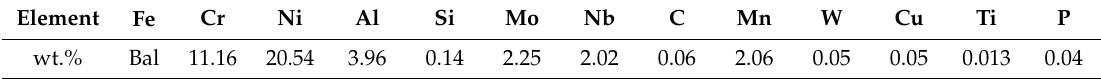
Table 1. Chemical composition of alumina-forming austenitic heat-resistant (AFA) steel (mass%). Element Fe Cr Ni Al Si Mo Nb C Mn W Cu Ti P wt.% Bal 11.16 20.54 3.96 0.14 2.25 2.02 0.06 2.06 0.013